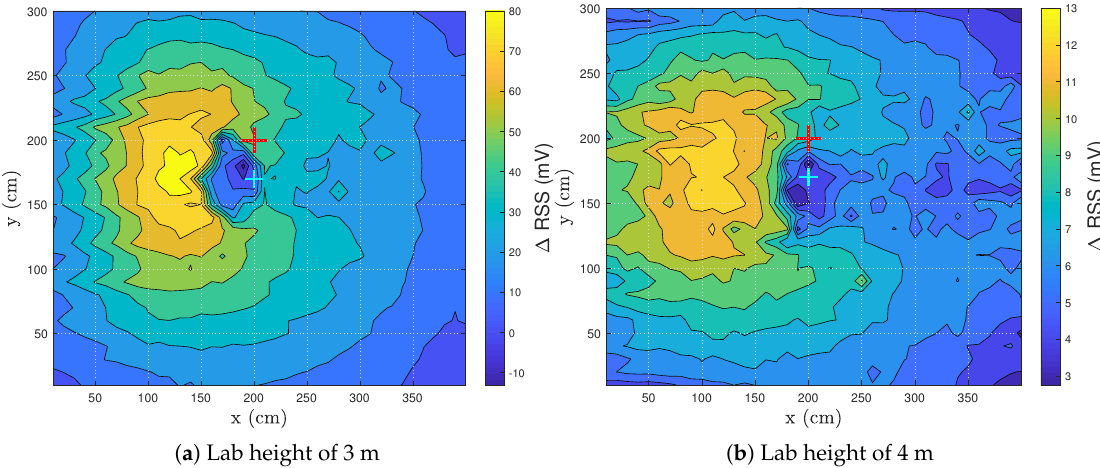
Figure 6. Visualization of the ∆ RSS distribution for different lab heights. The red cross represents the LED, while the cyan cross denotes the